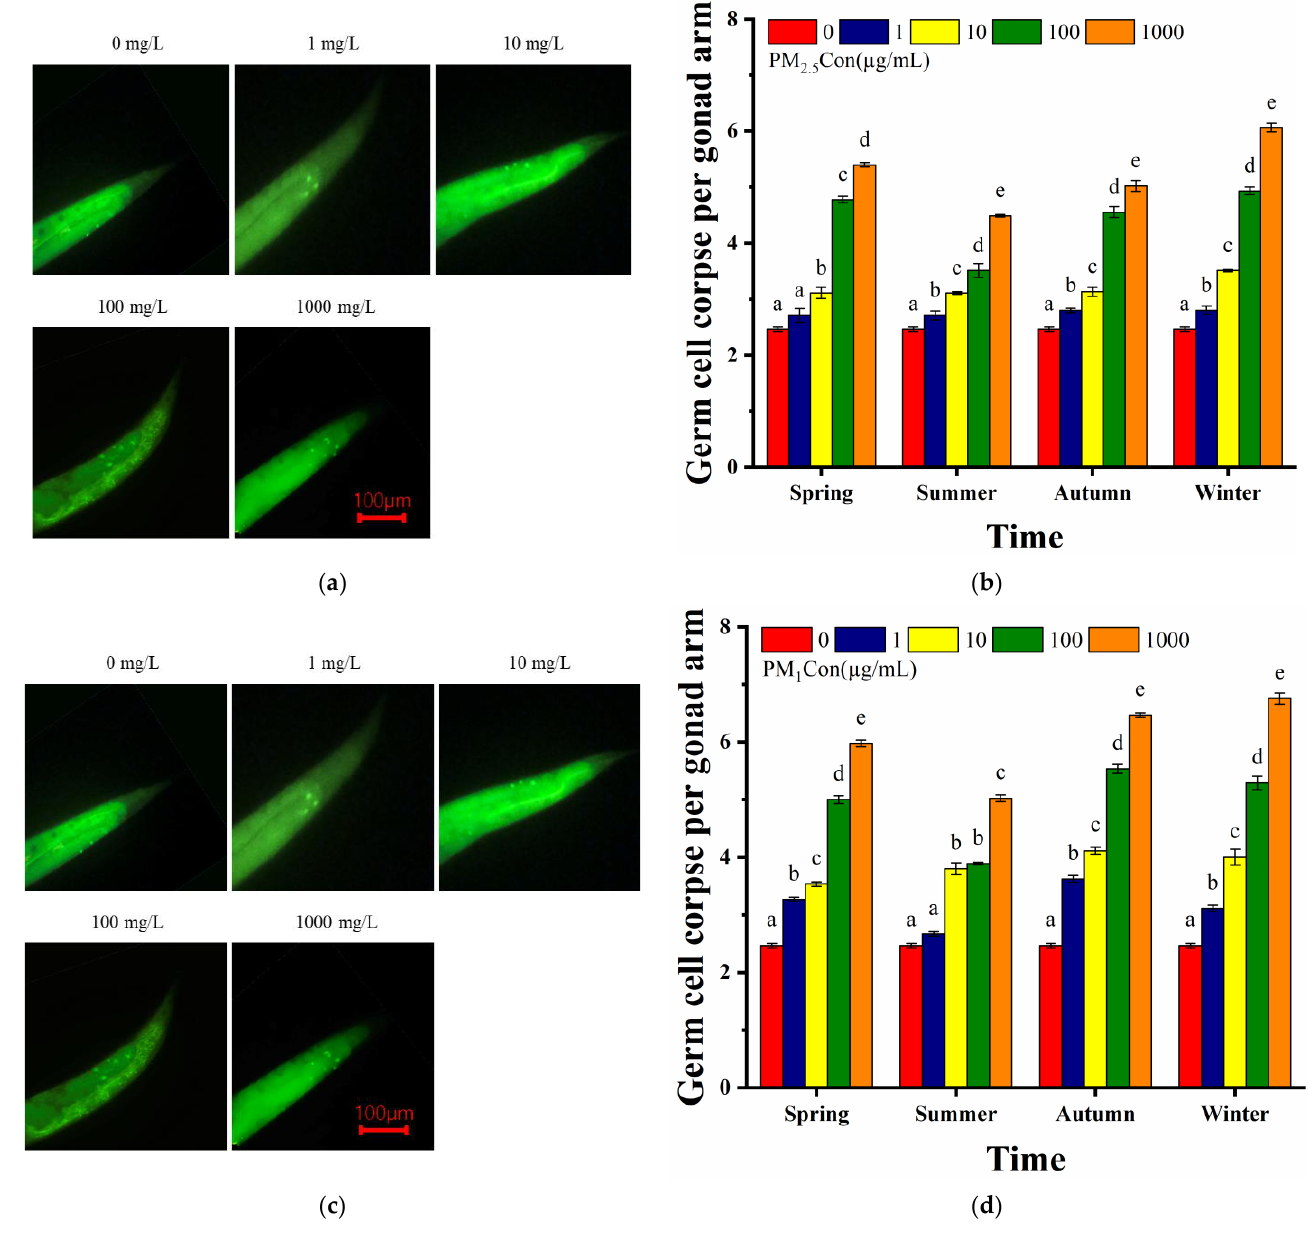
Figure 5. Effect of different seasons of PM exposure on nematodes germ cell apoptosis: ( a ) the plot of germ cell apoptosis at different PM 2.5 concentrations; ( b ) germ cell apoptosis of nematodes exposed to 1, 10, 100 and 1000 µg/mL of PM 2.5 in four seasons compared to the control; ( c ) the plot of germ cell apoptosis at different PM 1 concentrations; ( d ) germ cell apoptosis of nematodes exposed to 1, 10, 100 and 1000 µg/mL of PM 1 in four seasons compared to the control. L4 stage larvae were selected for 24 h acute exposure. Different letters (a, b, c, d, e) indicate significant differences among the five PM treatments in each season ( p < 0.05). Bars represent means ± SEM.